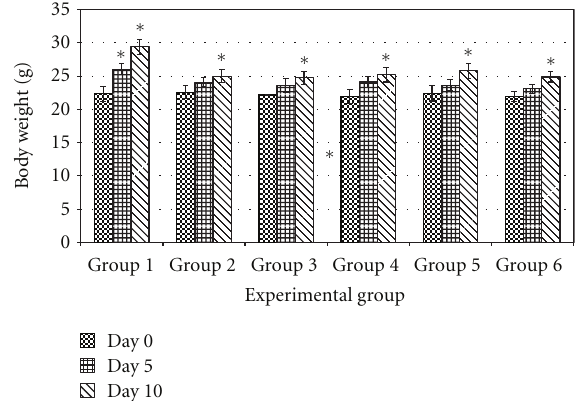
Figure 2: E ff ect of fermented, nonfermented mung bean and M. charantia extracts on body weight changes of alloxan-induced hyperglycemic mice after 10 days of treatment. ∗ P > 0 . 05 versus day